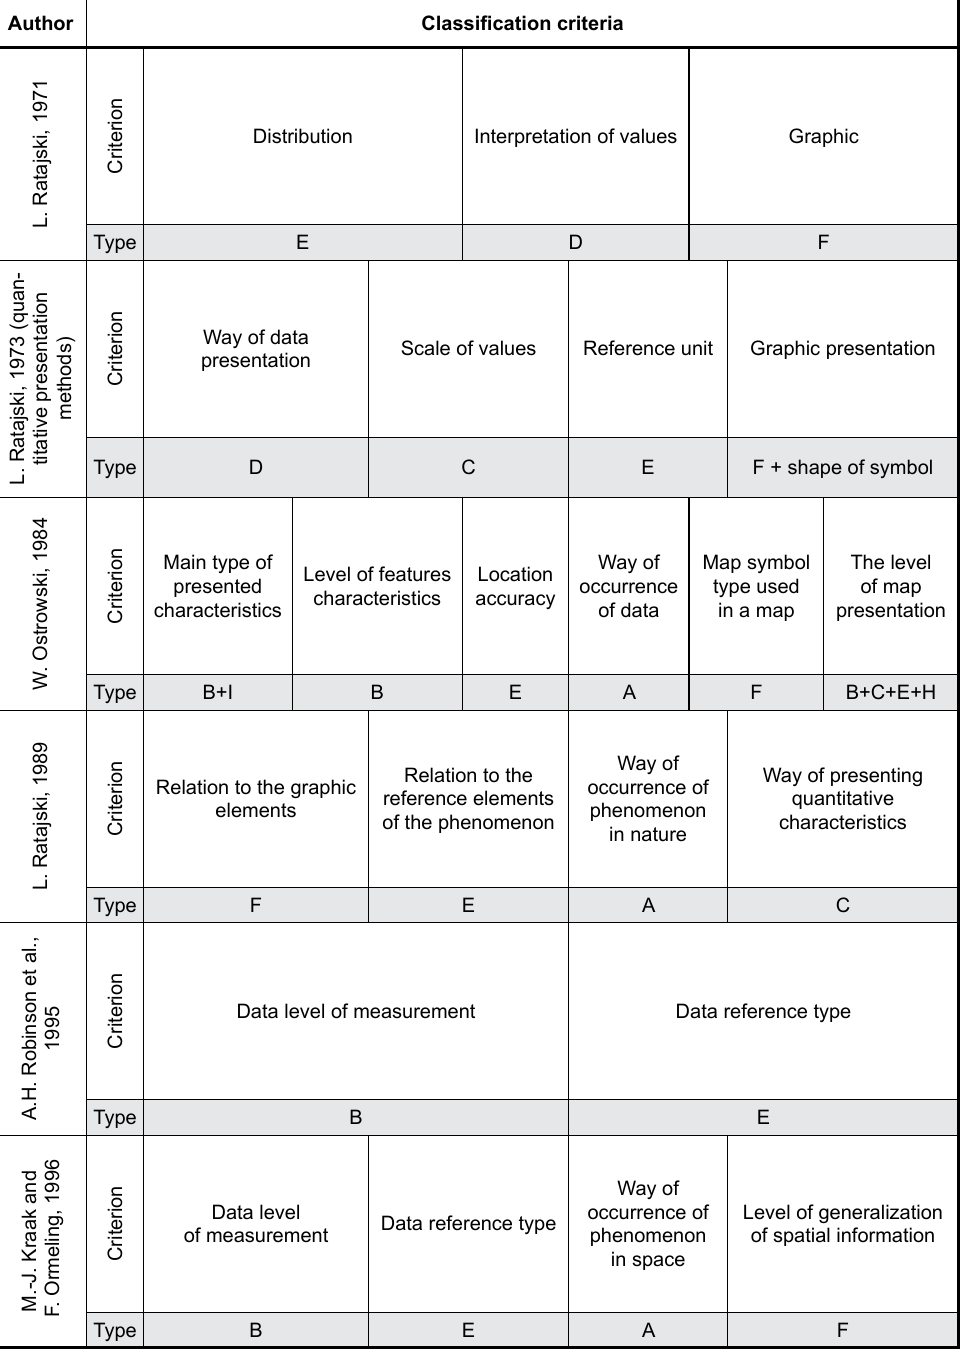
Tab. 1. Selected classification criteria of cartographic symbolization